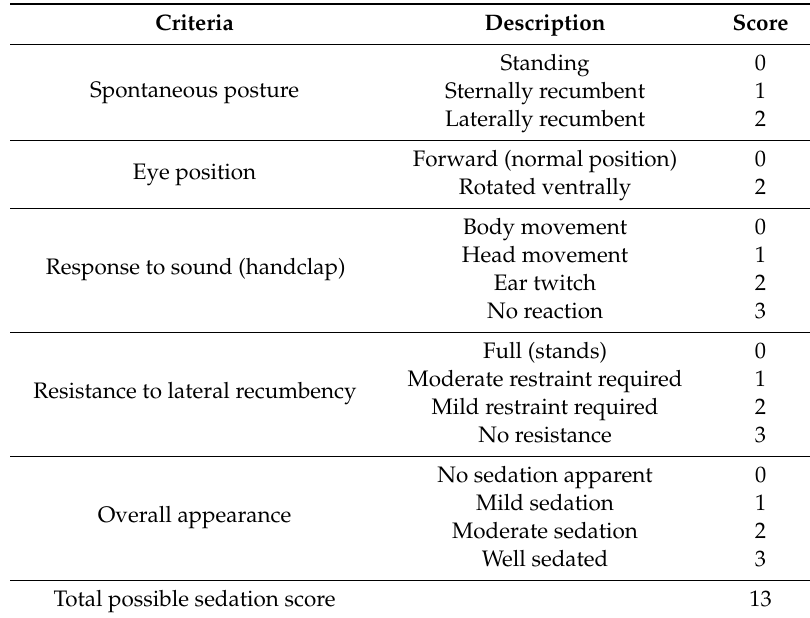
Table 1. Sedation modified numeric rating scale (adapted from Gurney et al., 2009